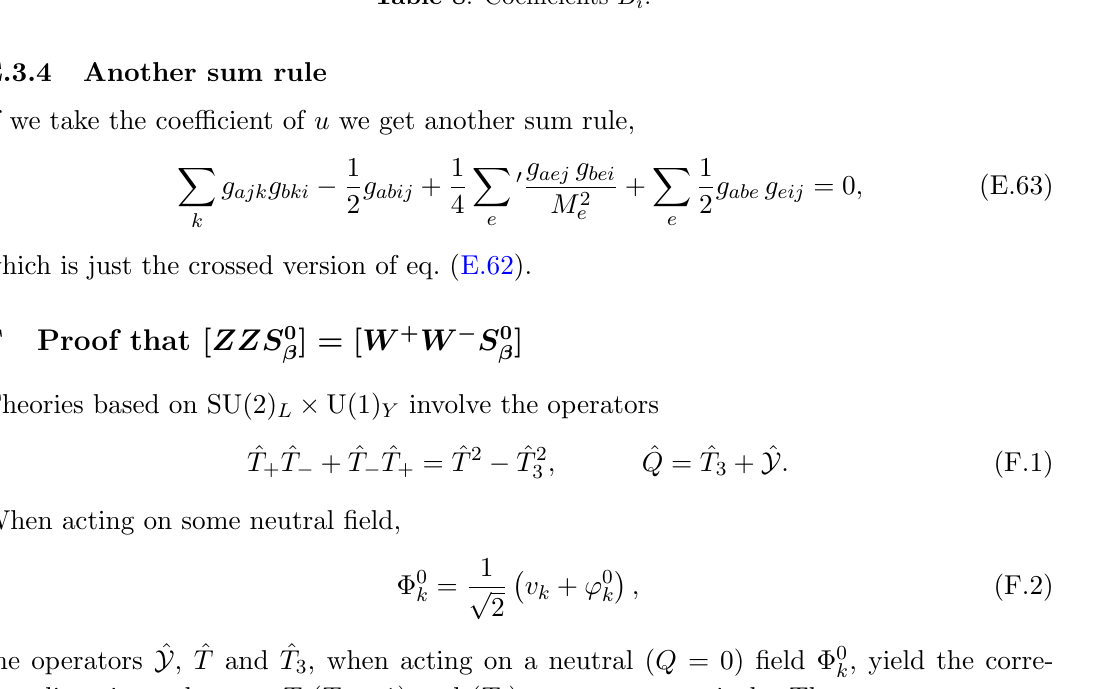
Table 8 . Coe(cid:14)cients ^ B i